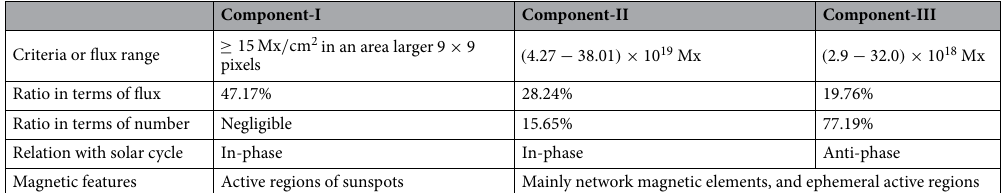
Table 1. Components of active regions and small-scale